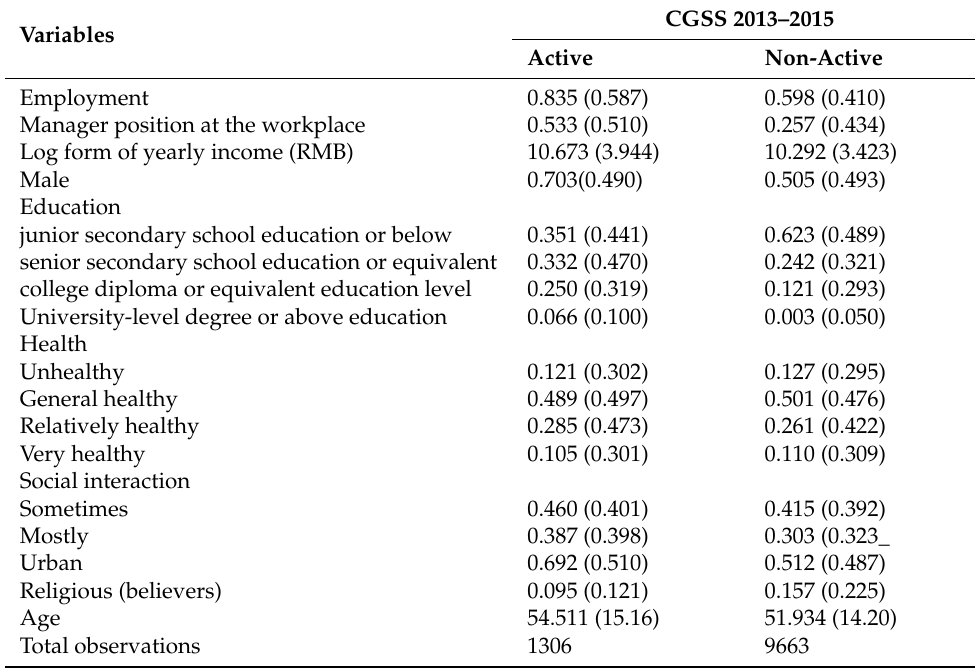
Table 2. General characteristics of individuals with active and non-active